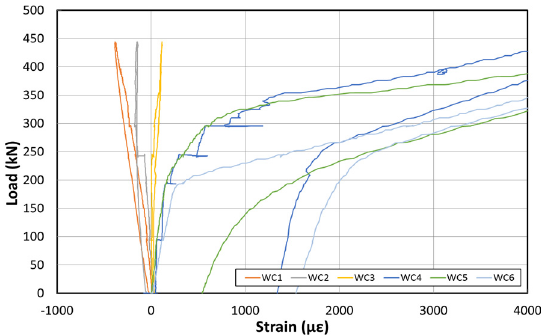
Figure 12. Concrete strain curve at the center before reinforcement based on the EP method.